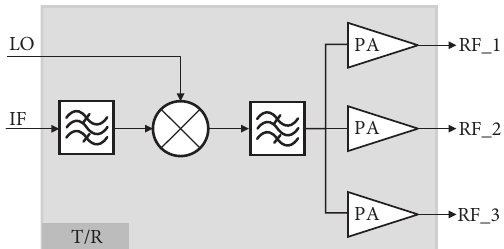
Figure 3: Each TR module has an IF input and three RF outputs, including filters, mixers and amplifiers.